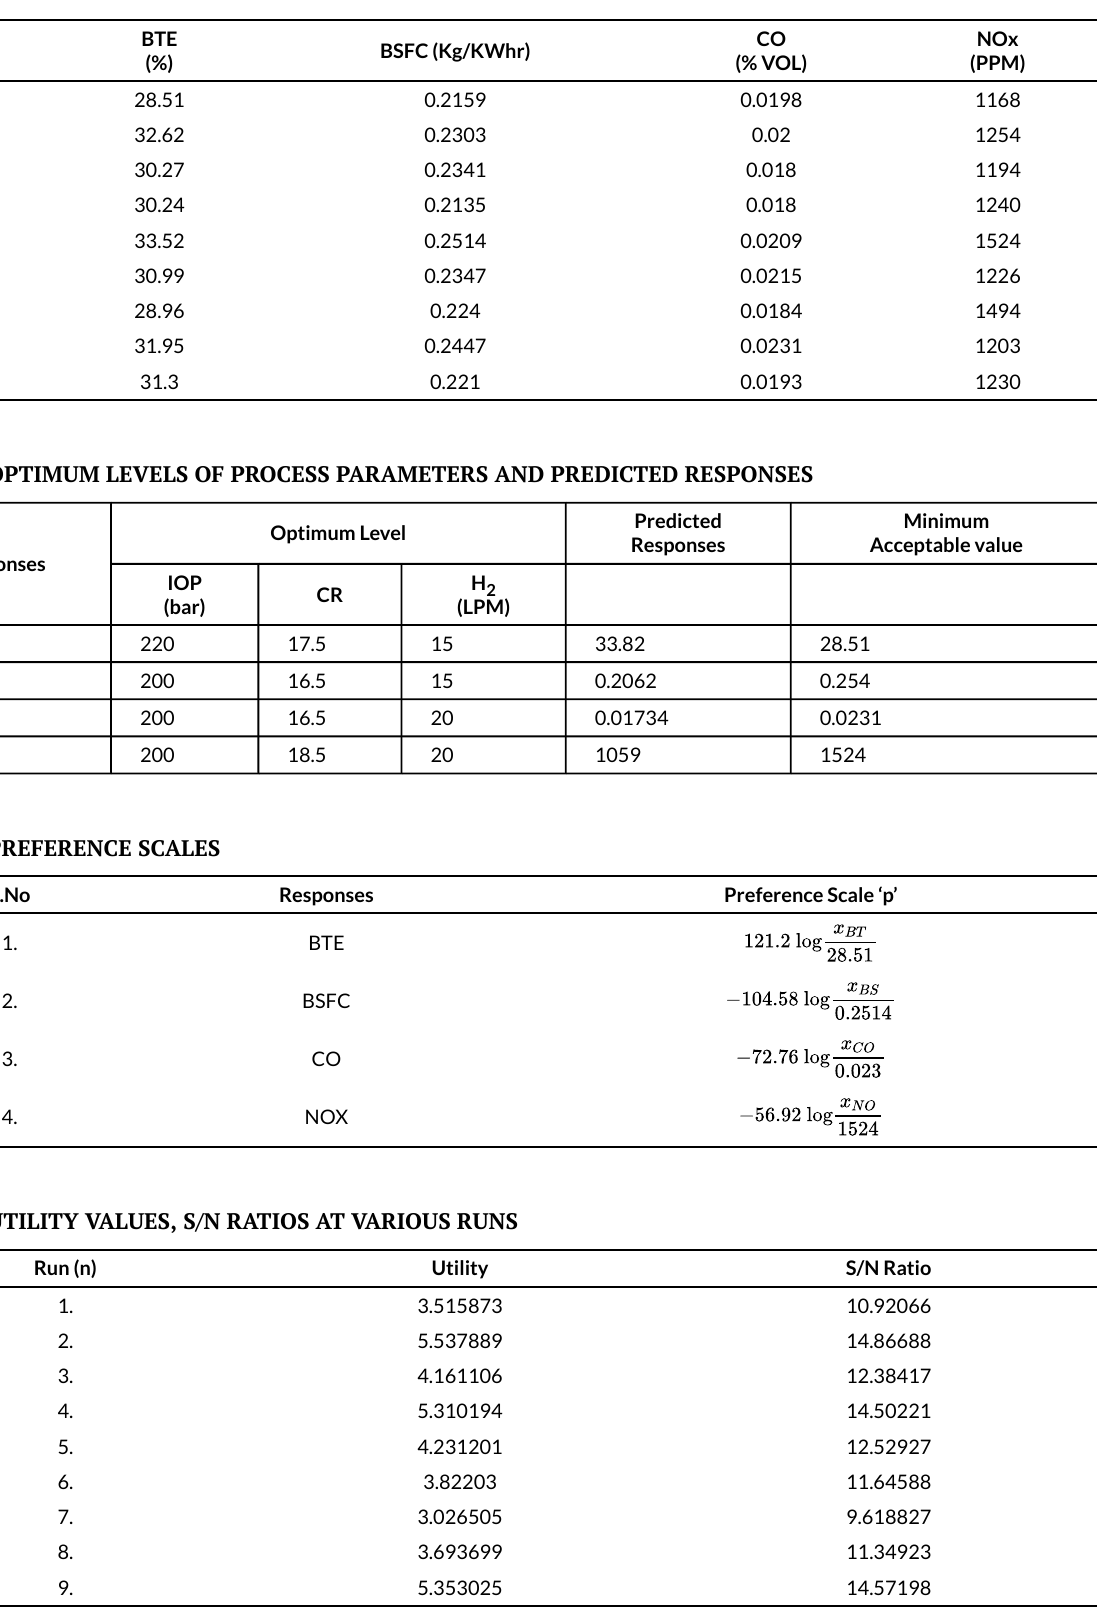
TABLE 2. EXPERIMENTAL RESULTS